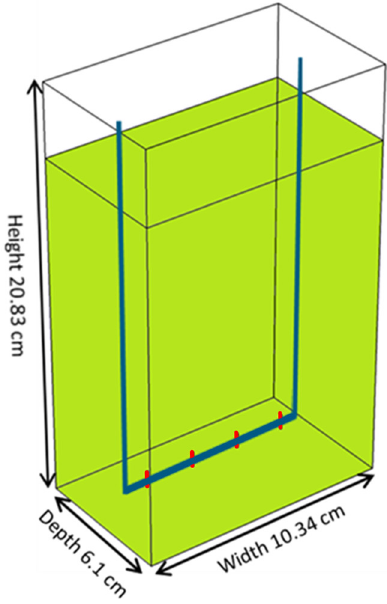
Figure 2. Three-dimensional schematic of the flat panel PBR used as the standard in this study. To study the effect of design parameters on the PBR productivity, two alternate designs middle to a quarter of the distance from the wall along the depth of the PBR; in addition